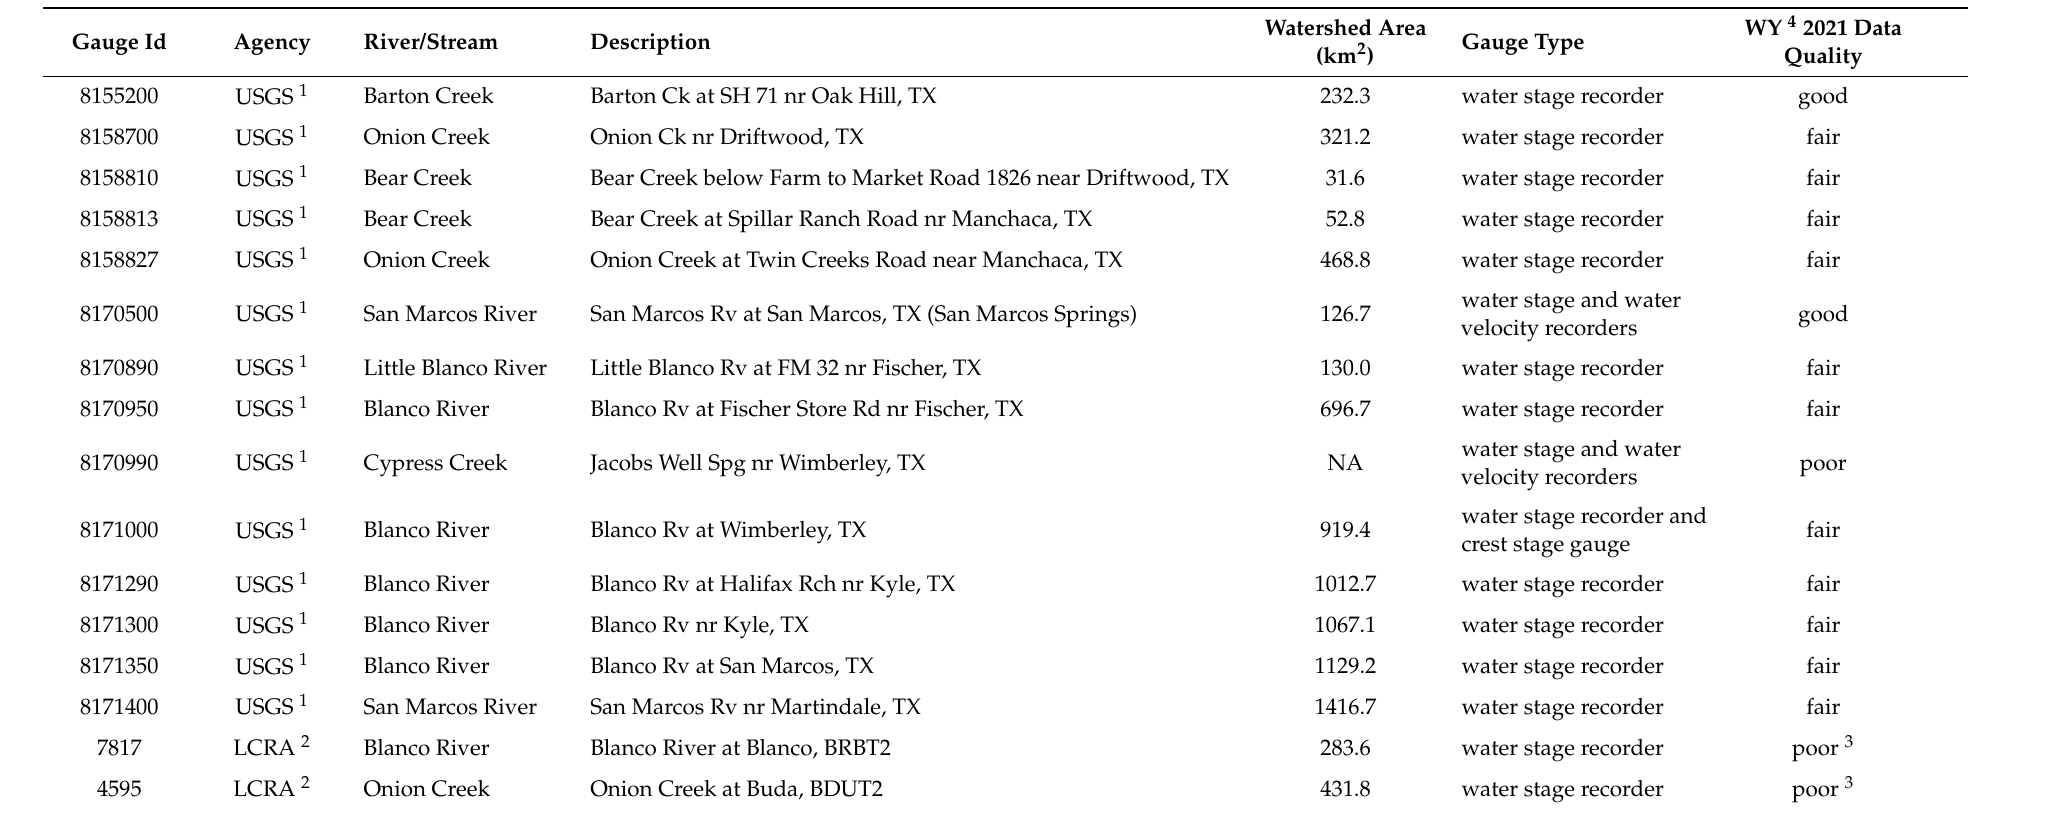
Table 1. Stream gauging station